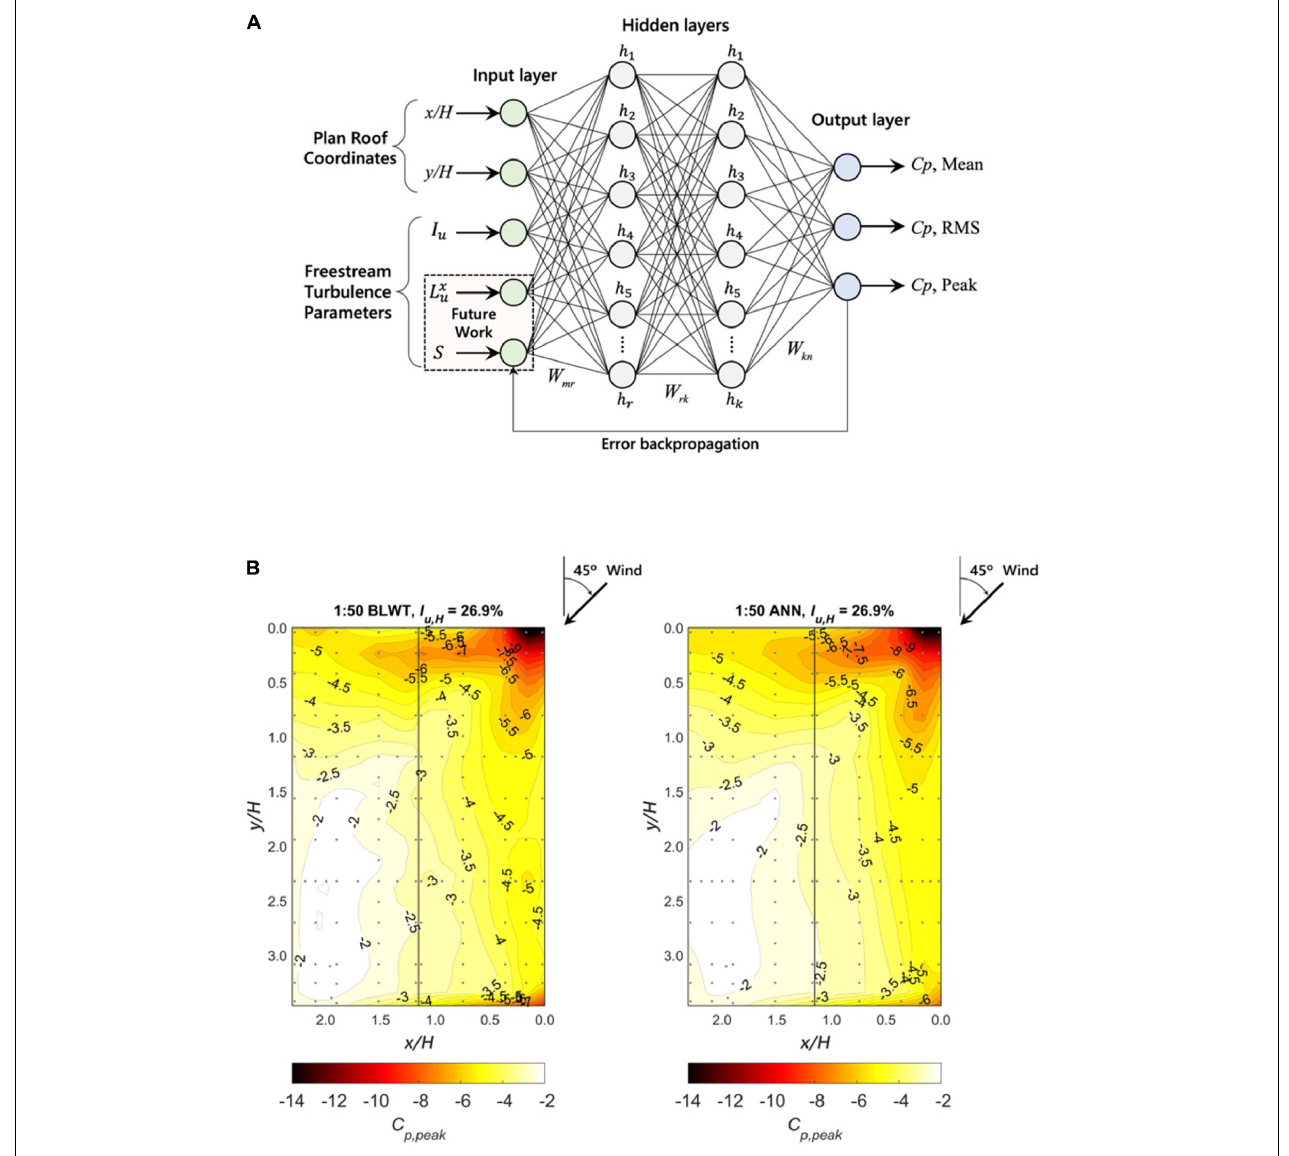
FIGURE 7 | (A) Architecture of an artificial neural network (ANN) for wind pressure prediction accounting for turbulence parameters. (B) Peak pressure contours of the 1:50 WERFL model: BLWT experimental data (left) and ANN model prediction (right) (from Fernández-Cabán et al., 2018 under the Creative Commons CC BY